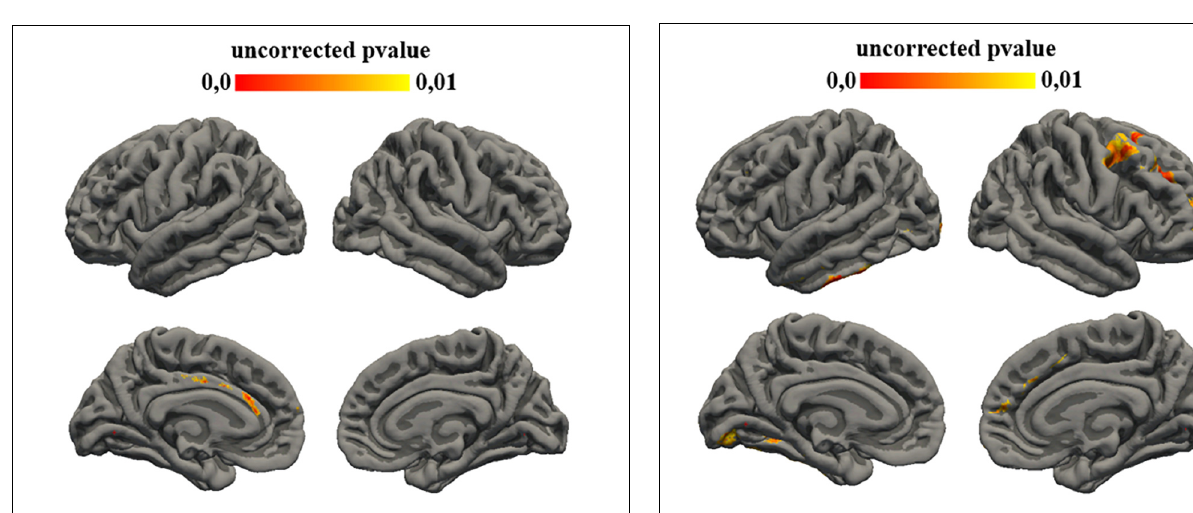
Frontiers in Neuroscience |